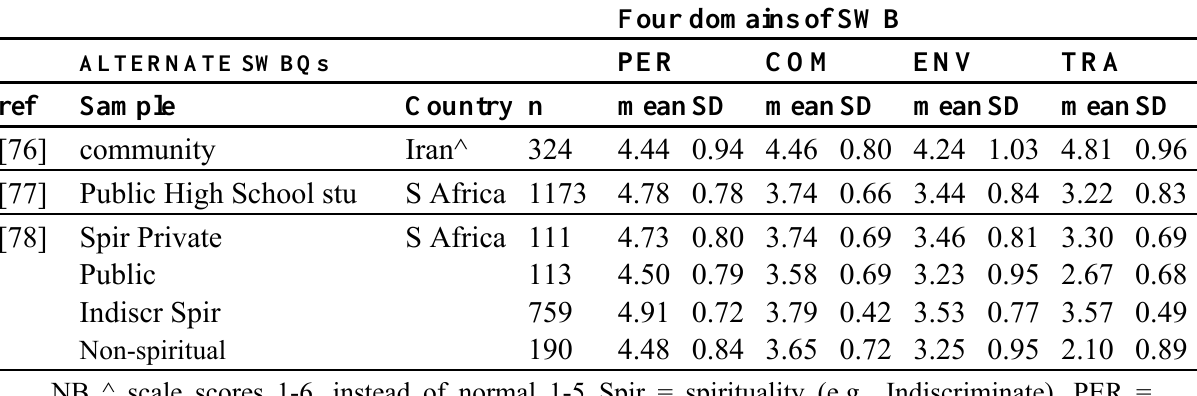
Table 5. Alternate versions of the SWBQ used to assess SWB. Four domains of